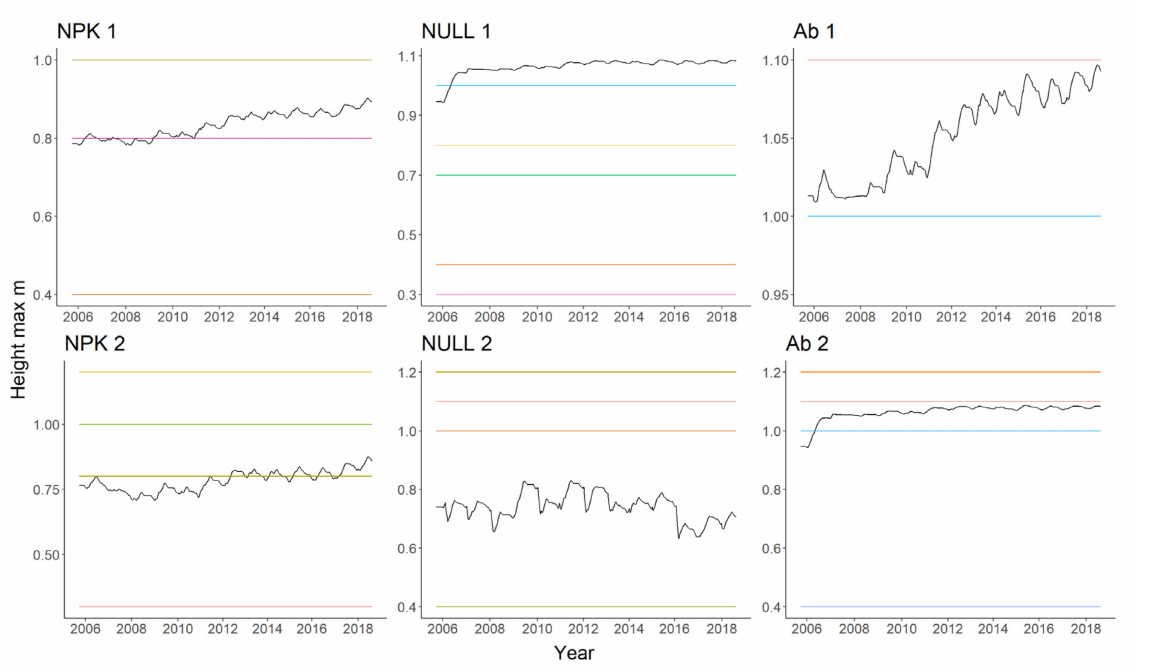
Figure 6. Daily changes in the maximum height of the community during the simulation period compared to the fixed values set for the plant species (coloured lines as in Figure 4) present in the community (horizontal lines, overlapping for the same values) for three treatments (NPK: fertilised; Null: unfertilised; Ab: abandoned) and two blocks (1,